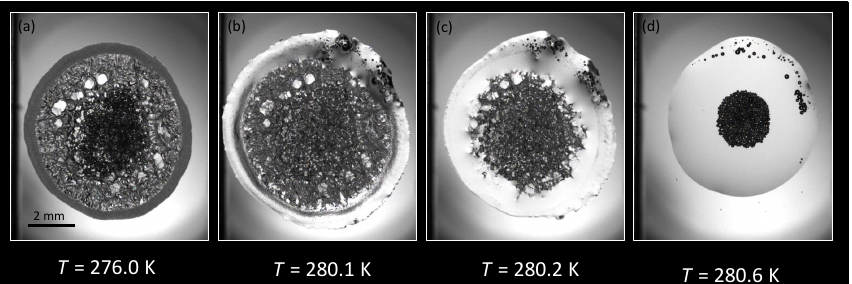
Figure 8. Dissociation sequence of a methane hydrate formed from an aqueous MEG solution, with uniform surface temperature. w MEG = 10%, p = 6.53 MPa, T HLV = 280.5 K. ( a ) Before hydrate dissociation. ( b ) Hydrate started to dissociate at the periphery of the droplet. ( c ) Continued dissociation towards the center of the droplet. ( d ) Complete hydrate